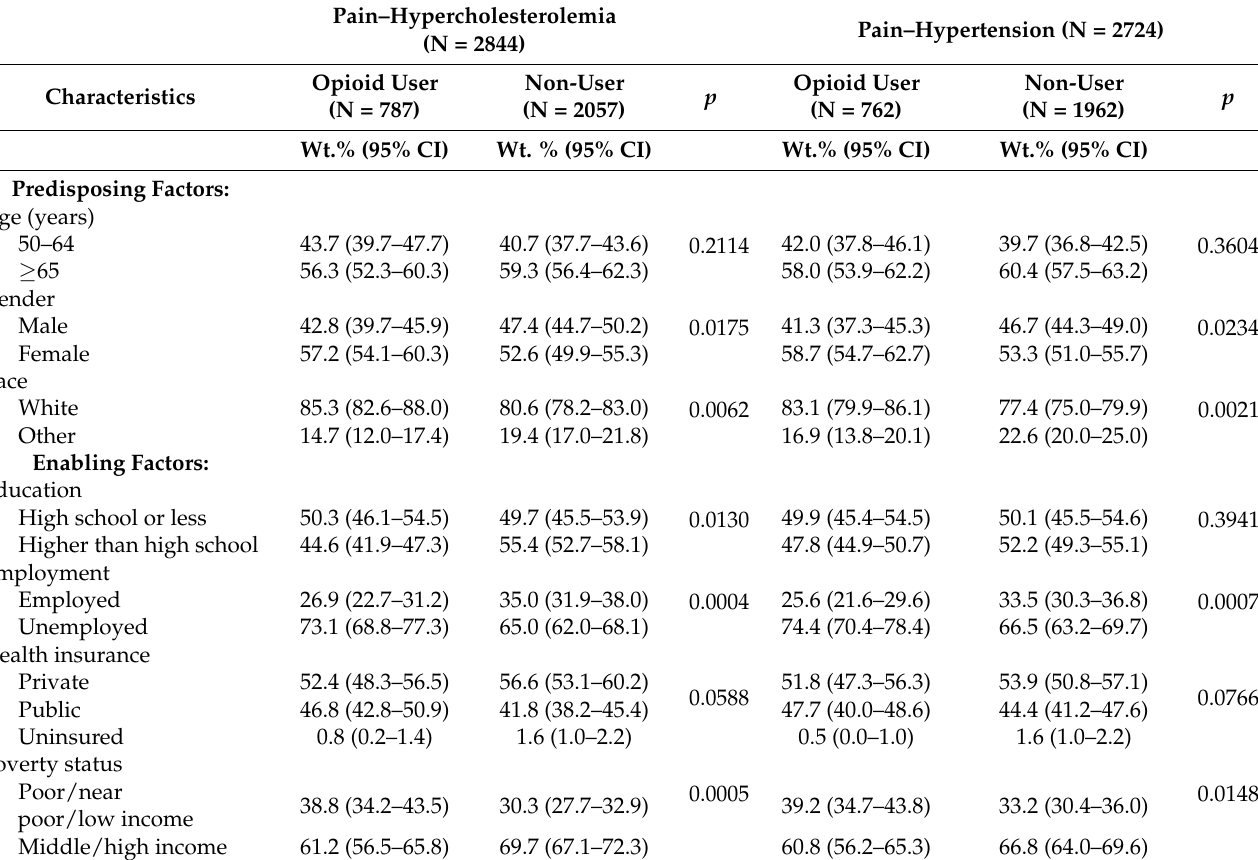
Table 1. Characteristics of United States older adults (age ≥ 50 years) with self-reported pain in the past four weeks and a diagnosis of hypercholesterolemia or